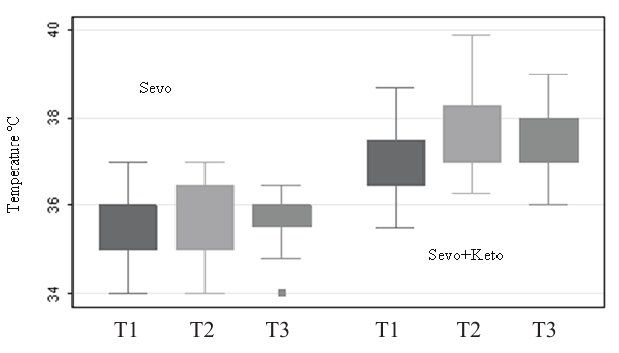
FIGURE 1 – Box-plot. Temperature mean and standard deviation values (ºC) of the rats of the sevoflurane+ketoprofen (sevo+keto) and sevoflurane (sevo) groups in the three time points studied T1, coincident with the first hemorrhage, T2, coincident with the third hemorrhage, and T3, 30 min after T2 (p=0.003, 0.0002, 0.0002 in T1, T2 and T3,